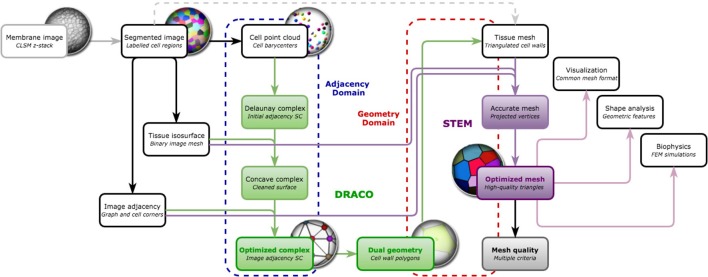
Overview of the DRACO-STEM components: DRACO (→) creates an adjacency complex by the image-based optimization of the Delaunay complex of cell barycenters and generates the dual geometry complex, and STEM (→) optimizes a triangular tissue mesh, coming from DRACO or not, along several meristem tissue specific criteria and estimates its quality. The algorithmic components operate either on adjacency complexes (- - - ) in the case of DRACO or geometry complexes (- - - ).